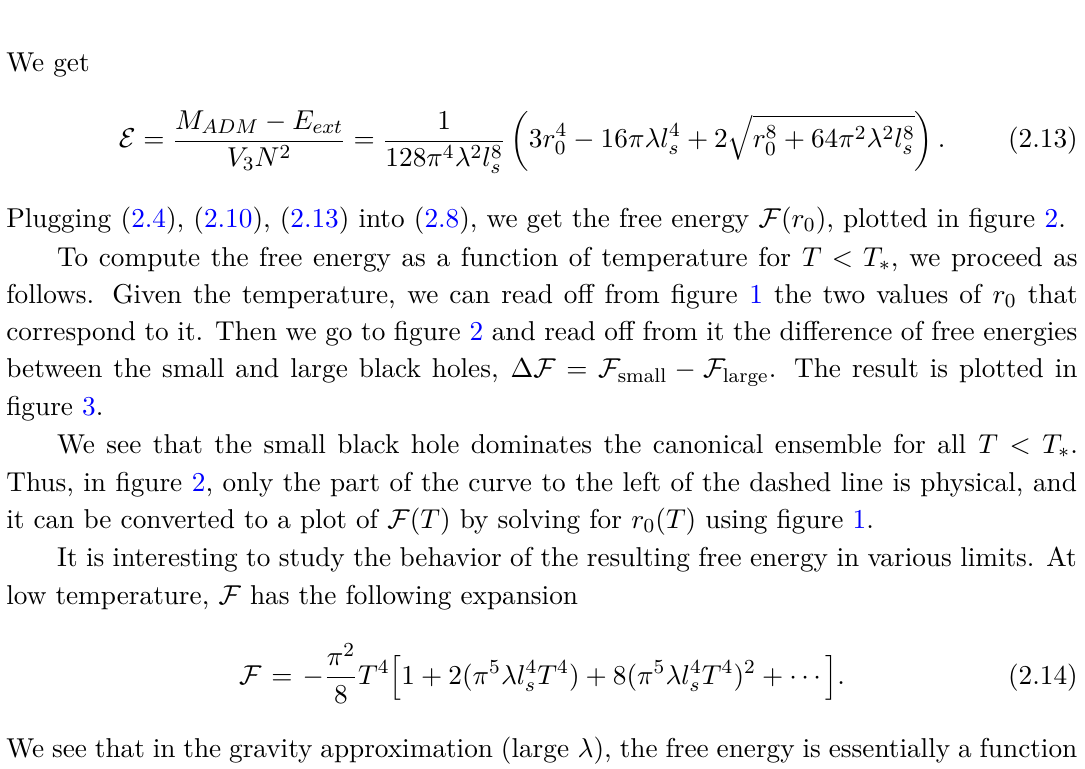
Figure 3 . For all T < T ∗ , the small black hole has lower free energy than the large one with the same temperature T